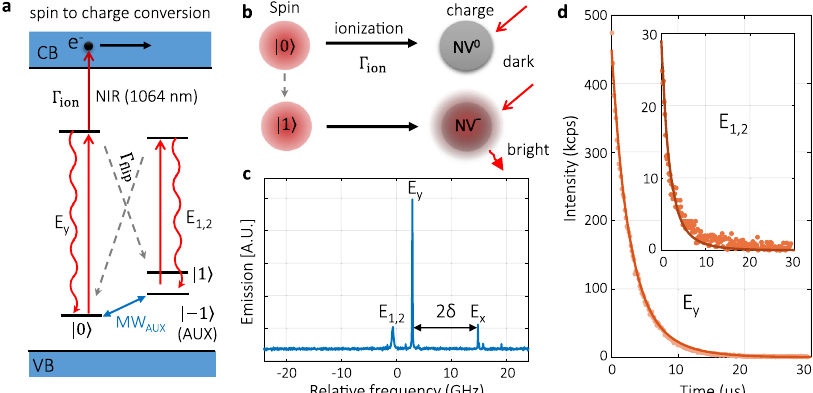
Fig. 1 Single-shot readout scheme based on SCC. a Energy levels used to achieve SCC. Qubit is encoded in the ground state 0 j i and 1 j i , and the (cid:2) 1 j i ¼ AUX j i state acts as the auxiliary level. The magnetic fi eld of 585 G aligned to NV axis lifts the degeneracy between (cid:2) 1 j i and þ 1 j i . Note that the magnitude and direction of the magnetic fi eld used here is not special. The coherent manipulation between 0 j i and ± 1 j i can be realized by resonant microwave, labeled by blue arrows. E y ( E 1,2 ) corresponds to the optical transition of the m S = 0 ( m S = ±1) state. The counts rate is proportional to the excited state emission rate and the fl uorescence photon collection ef fi ciency. The key part of SCC is to ionize (dark red arrow) the excited states of m S = 0 before it substantially relaxes to the ground ± 1 j i states through the spin- fl ip relaxation process (gray dashed arrow). CB is the conduction band of diamond and VB the valance band. Γ ion denotes the ionize rate, and Γ fl ip denotes the spin- fl ip rate from the E y excited state to the ground ± 1 j i states. A more detailed model is in Supplementary information (SI). b A schematic diagram of SCC readout. Under the illumination of 637 nm laser, NV − keeps fl uorescing stably for a long time, while NV 0 is not excited. c The excitation spectrum of the NV center used here at cryogenic temperature of 8 K. Frequency is given relative to 470.4675THz (637.2225nm). The non-axial strain ( δ ) induces a splitting of 2 δ = 11.8 GHz between E y and E x transitions 45 . d Spin- fl ip process induces the photoluminescence (PL) decay under E y excitation (5.7 nW, saturation power ~13 nW) with NV initially prepared in 0 j i . At the fi nal equilibrium of PL decay curve, the NV spin is pumped into ± 1 j i . The solid line is the simulation according to the model described in SI, with the best- fi tted spin- fl ip rate Γ fl ip = 0.75 ± 0.02 MHz. Inset: PL decay for NV initialized to ± 1 j i under E 1,2 excitation (4.2 nW, saturation power ~ 34 nW). From the PL decay curves, the spin initialization fi delity is estimated to be 99.7 ± 0.1% for ± 1 j i subspace and 99.8 ± 0.1% for 0 j i